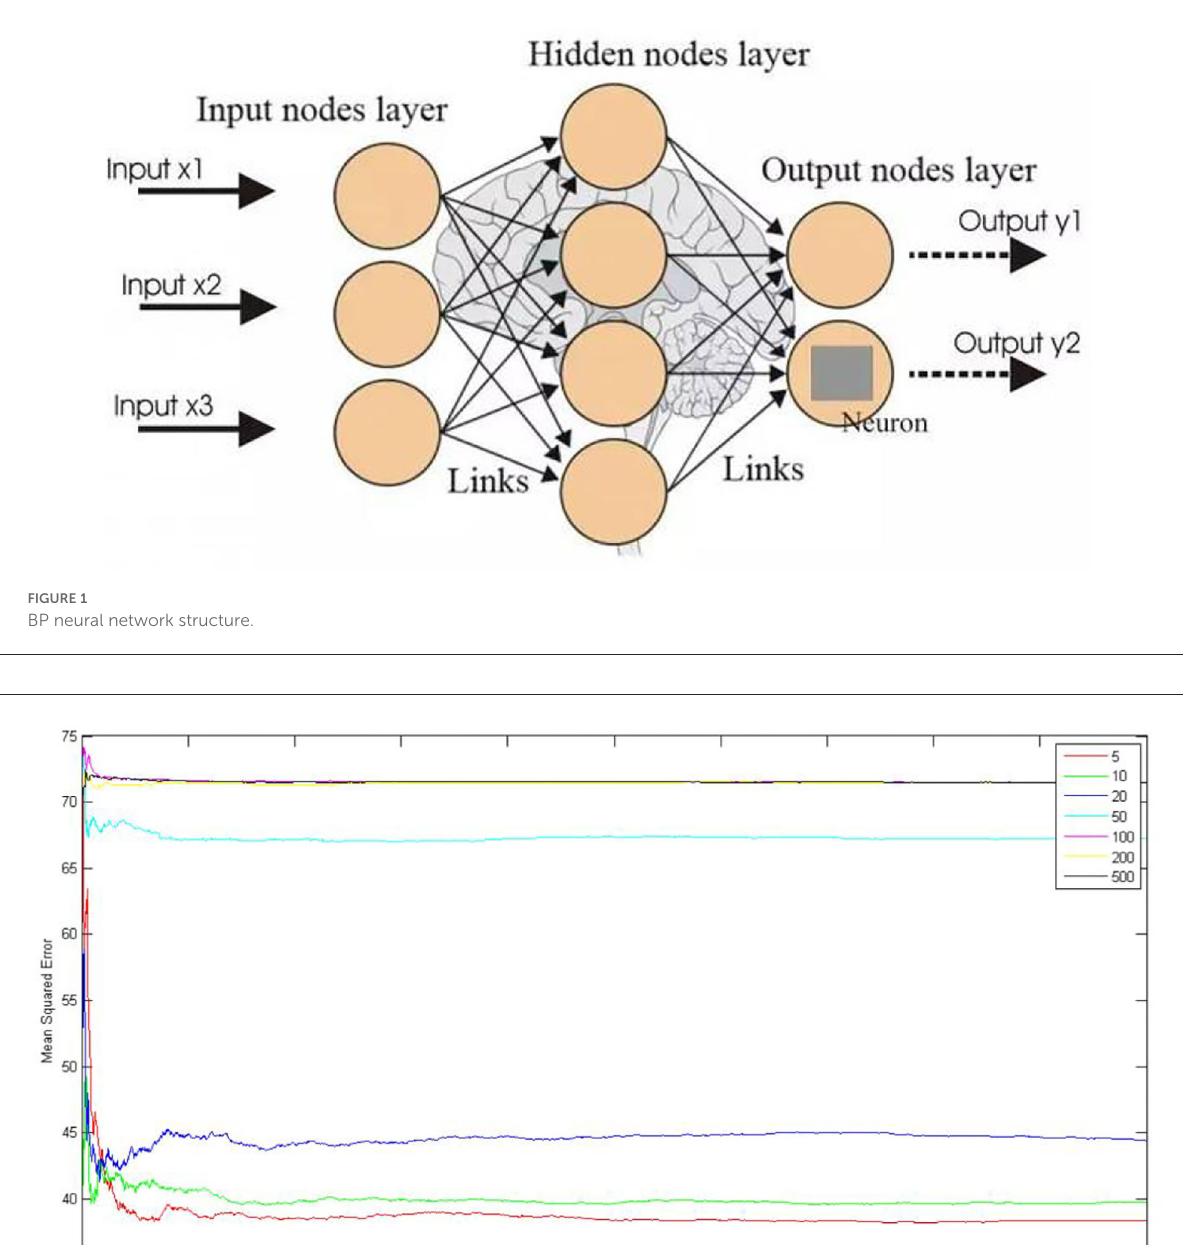
N OOB is the number of out-of-bag sample data. f ( x n ) is the n th sample value of out-of-bag data. f k ( x n ) and f k ( x ′ n ) are the estimated value of the n th sample before and after replacing variables. I ( · ) is the discriminant function whose value is set as 1 when the condition in parentheses is valid and 0